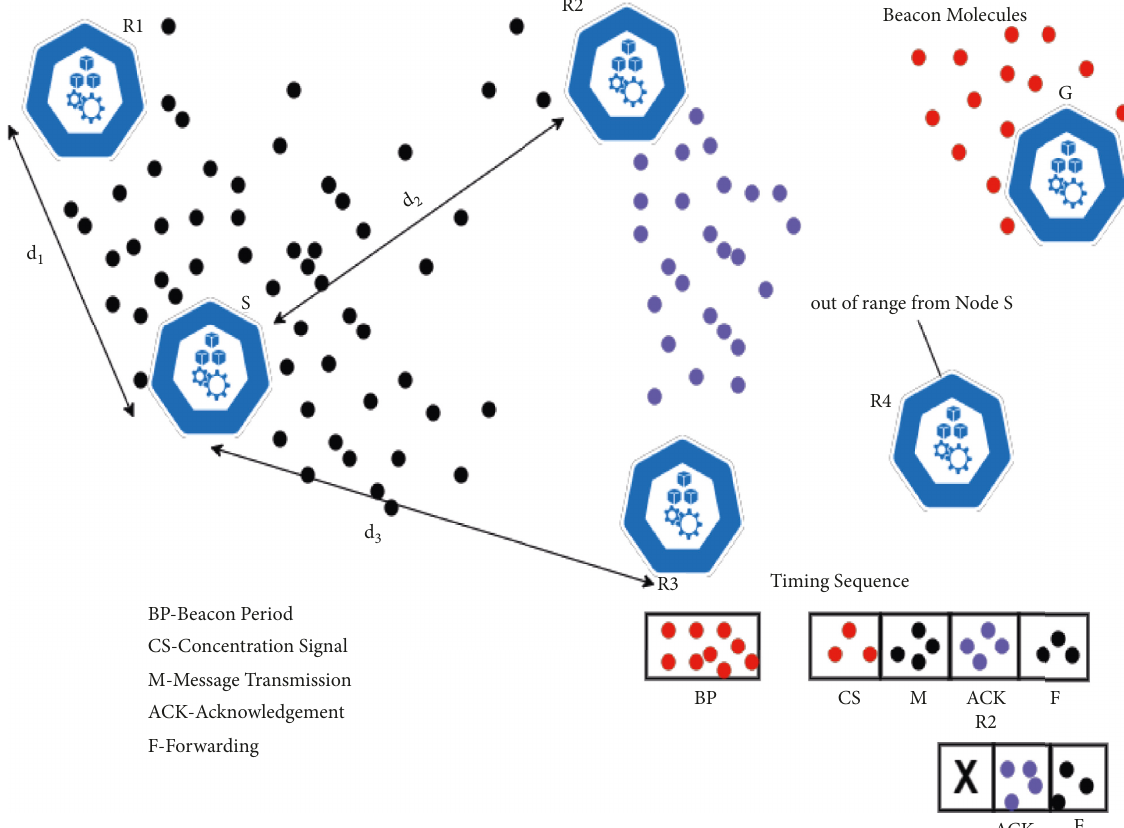
Figure 11: Proposed model of OR-DMC, ACK, timing sequence, and different types of messages are